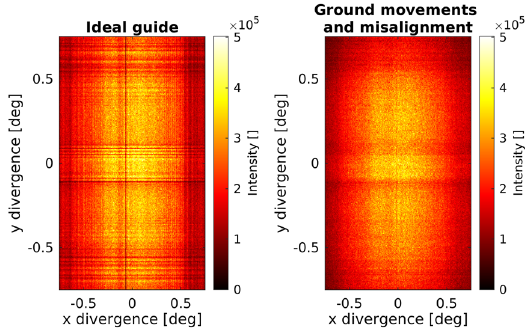
FIG. 12. Simulated divergence profile at the BIFROST sample position, integrated over the spectrum of the cold ESS moderator. The left panel shows results for the ideal guide, and the right panel for σ ¼ 50 μ m and ground movements of 6 mm. In the color scale, yellow represents the highest